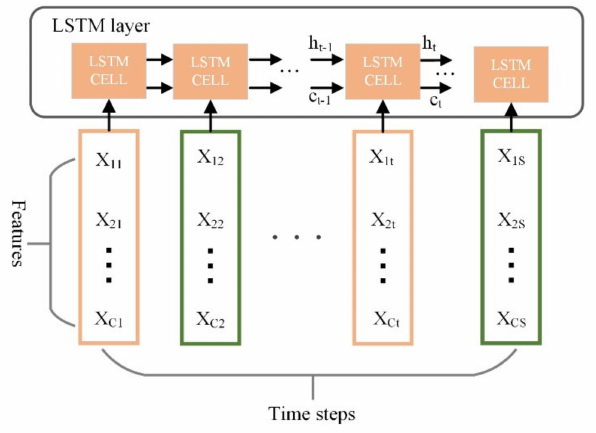
Figure 5. LSTM work schematic